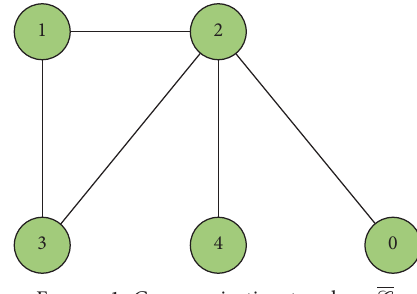
Figure 1: Communication topology G .